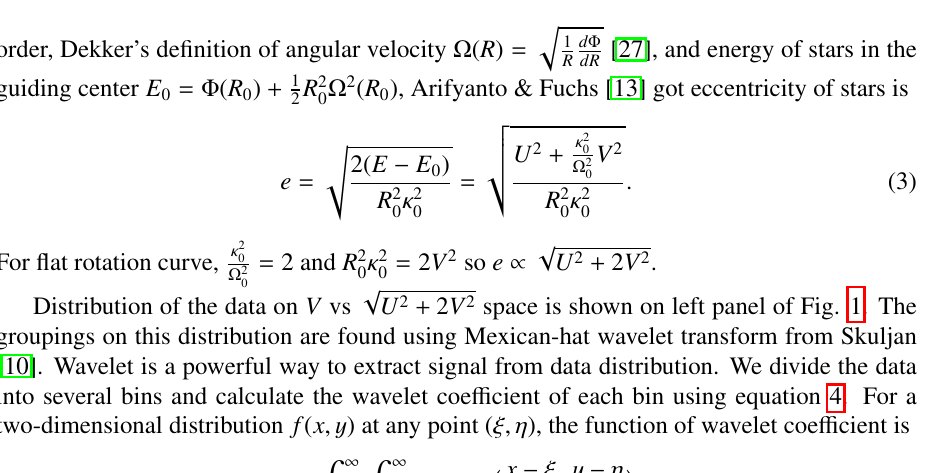
Fig. 1. Sample data distribution on V vs tion of the data in range of the red box is shown on the right panel